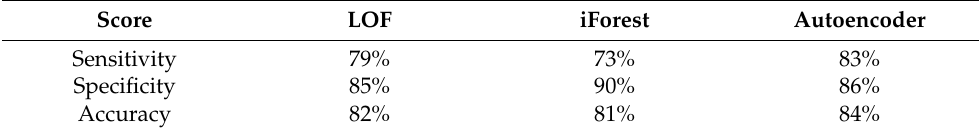
Table 2. Sensitivity and specificity scores for LOF, iForest, and